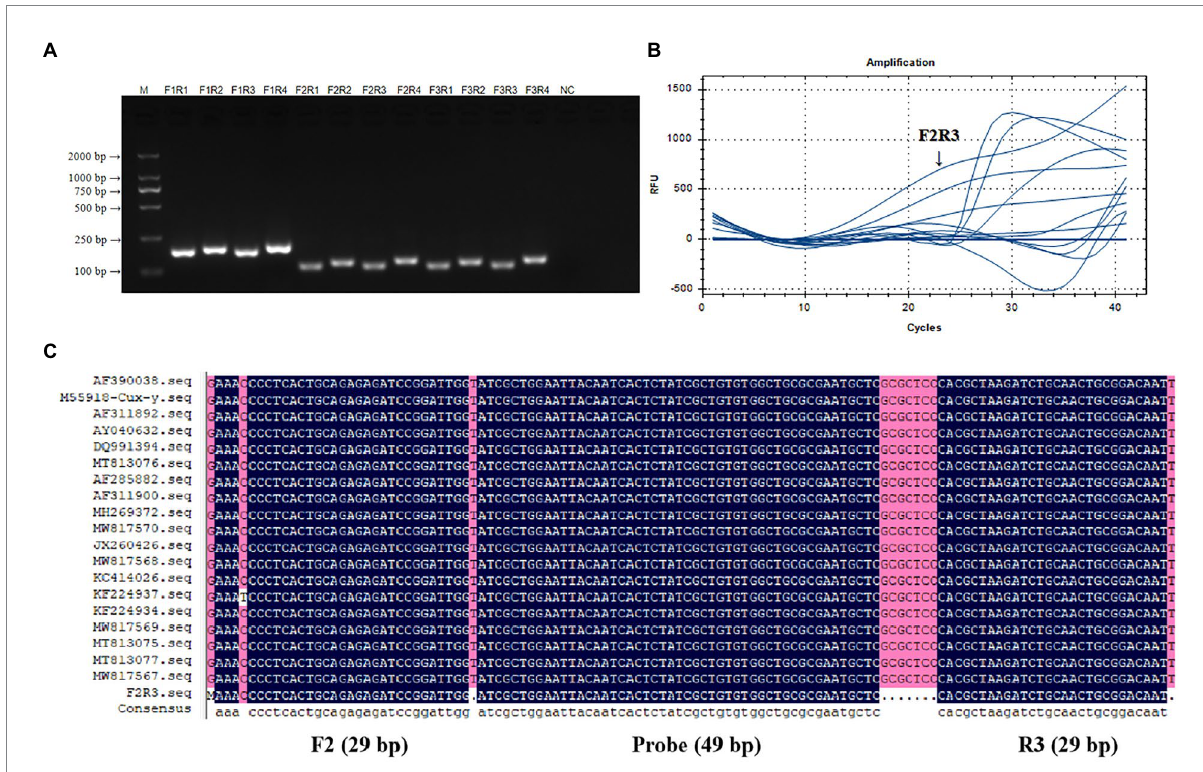
FIGURE 2 Verification and screening of real-time RAA Primers for CIAV. Twelve groups of real-time RAA primers for CIAV were F1R1, F1R2, F1R3, F1R4, F2R1, F2R2, F2R3, F1R4, F3R1, F3R2, F3R3, and F1R4 that verified by PCR amplification (A) and real-time RAA assay (B) . F2R3 had a higher amplification efficiency than the other primers in real-time RAA assay, with a 117 bp specific band size and no-primer-dimers in 1.5% gel electrophoresis. (C) A multiple sequence alignment of the F2R3 and probe sequences with the primers’ information amplification length. M, D 2000 Marker; N, negative control, i.e., ddH 2 O. RAA, recombinase-aided amplification assay; CIAV, Chicken Infectious Anemia Virus.